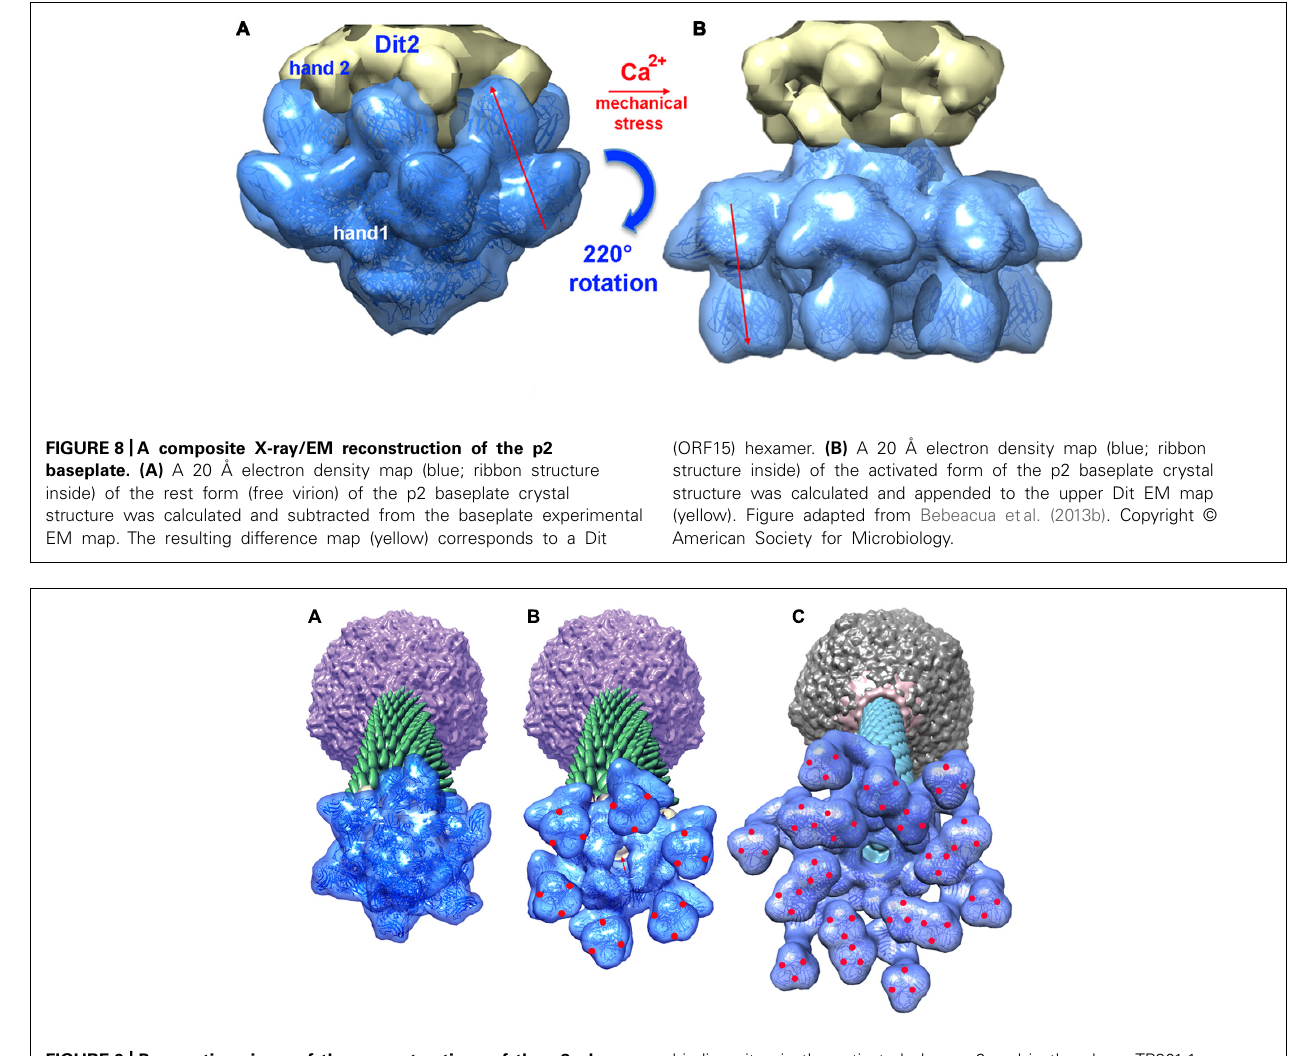
binding sites in the activated phage p2 and in the phage TP901-1 representations. Red arrow identifies the open channel of phage p2 activated baseplate. Panels (A,B) adapted from Bebeacua etal. (2013b). Copyright © American Society for